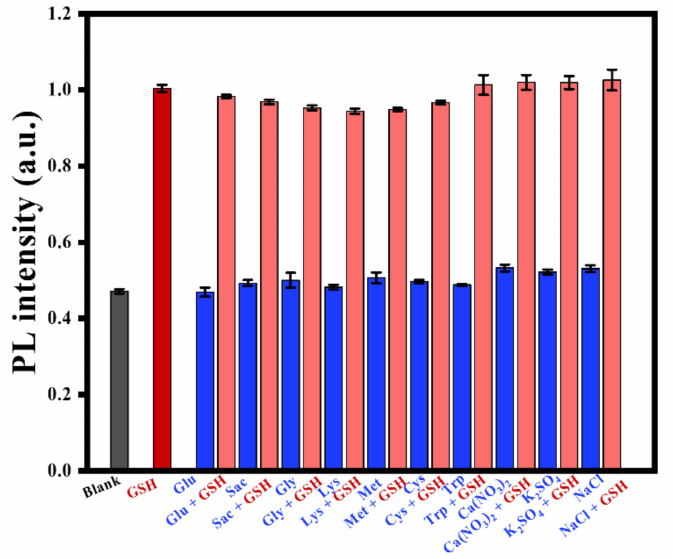
Figure 9. Fluorescent response of the NPCD-MnO 2 composite with the addition of 200 µ M of different substances including Glucose (Glu), Saccharose (Sac), Glycine (Gly), Lysine (Lys), Methionine (Met), Cysteine (Cys), Tryptophan (Trp), Ca(NO 3 ) 2 , K 2 SO 4 , and